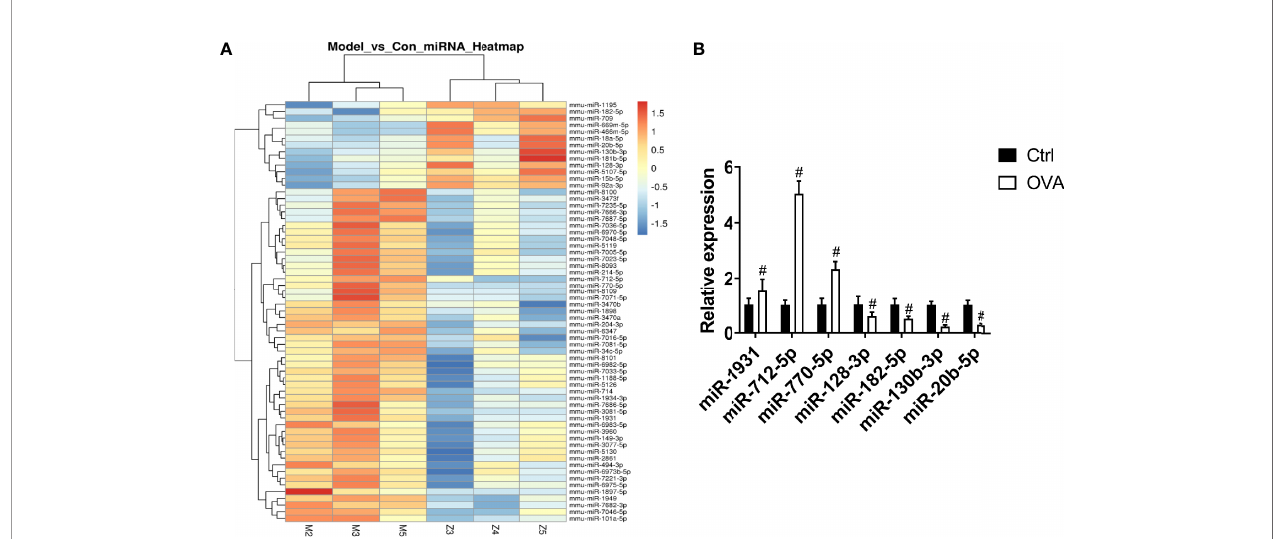
FIGURE 1 | Comparison of miRNA differential expression in asthma models. (A) Hierarchical clustering of differential miRNAs. Red indicates up-regulated genes and green indicates down-regulated genes in asthma. (B) Real-time PCR was used to determine the expression changes of miR-1931, miR-712-5p, miR-770-5p, miR-